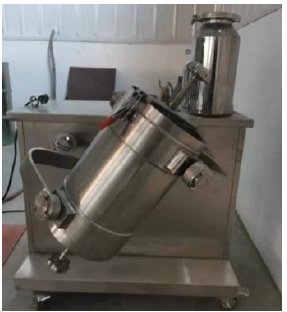
Figure 4. SYH-5 (10) type three-dimensional movement